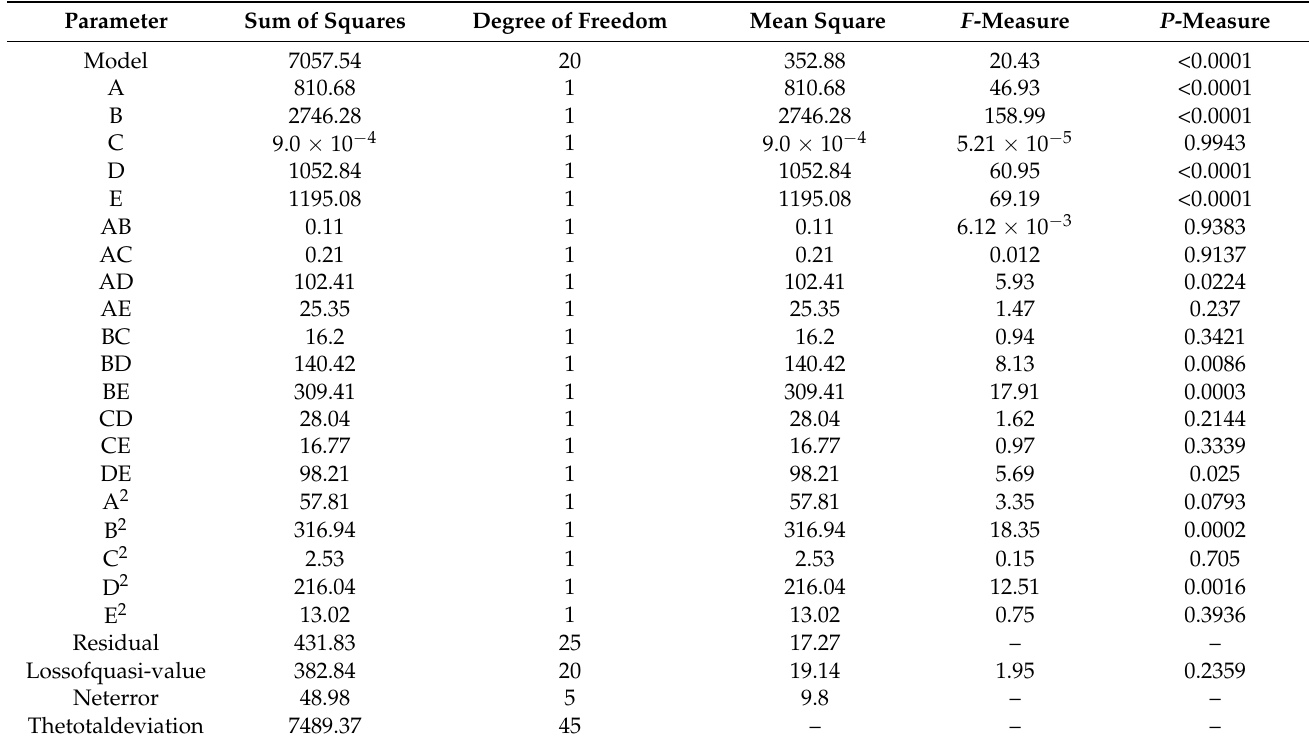
Table 3. AVOVA analyses are for variance of the